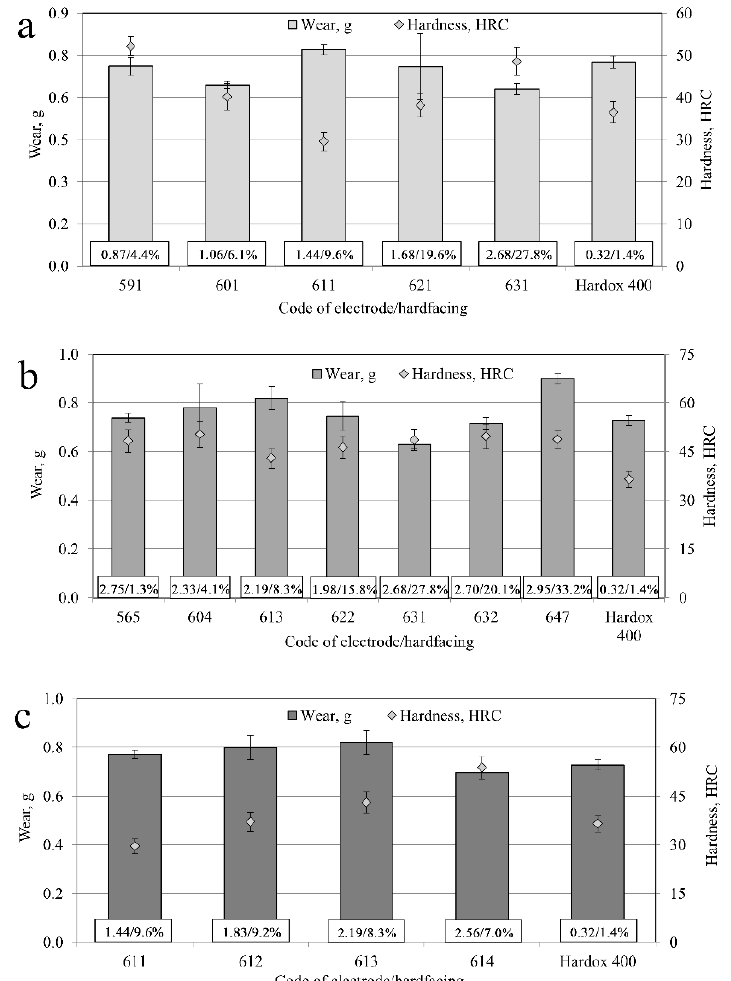
Figure 7. Effect of chromium and carbon ( a ), chromium ( b ), and carbon ( c ) on the wear rate and hardness of hardfacings under average-stress abrasive conditions (the content of C/Cr is indicated, wt.%).